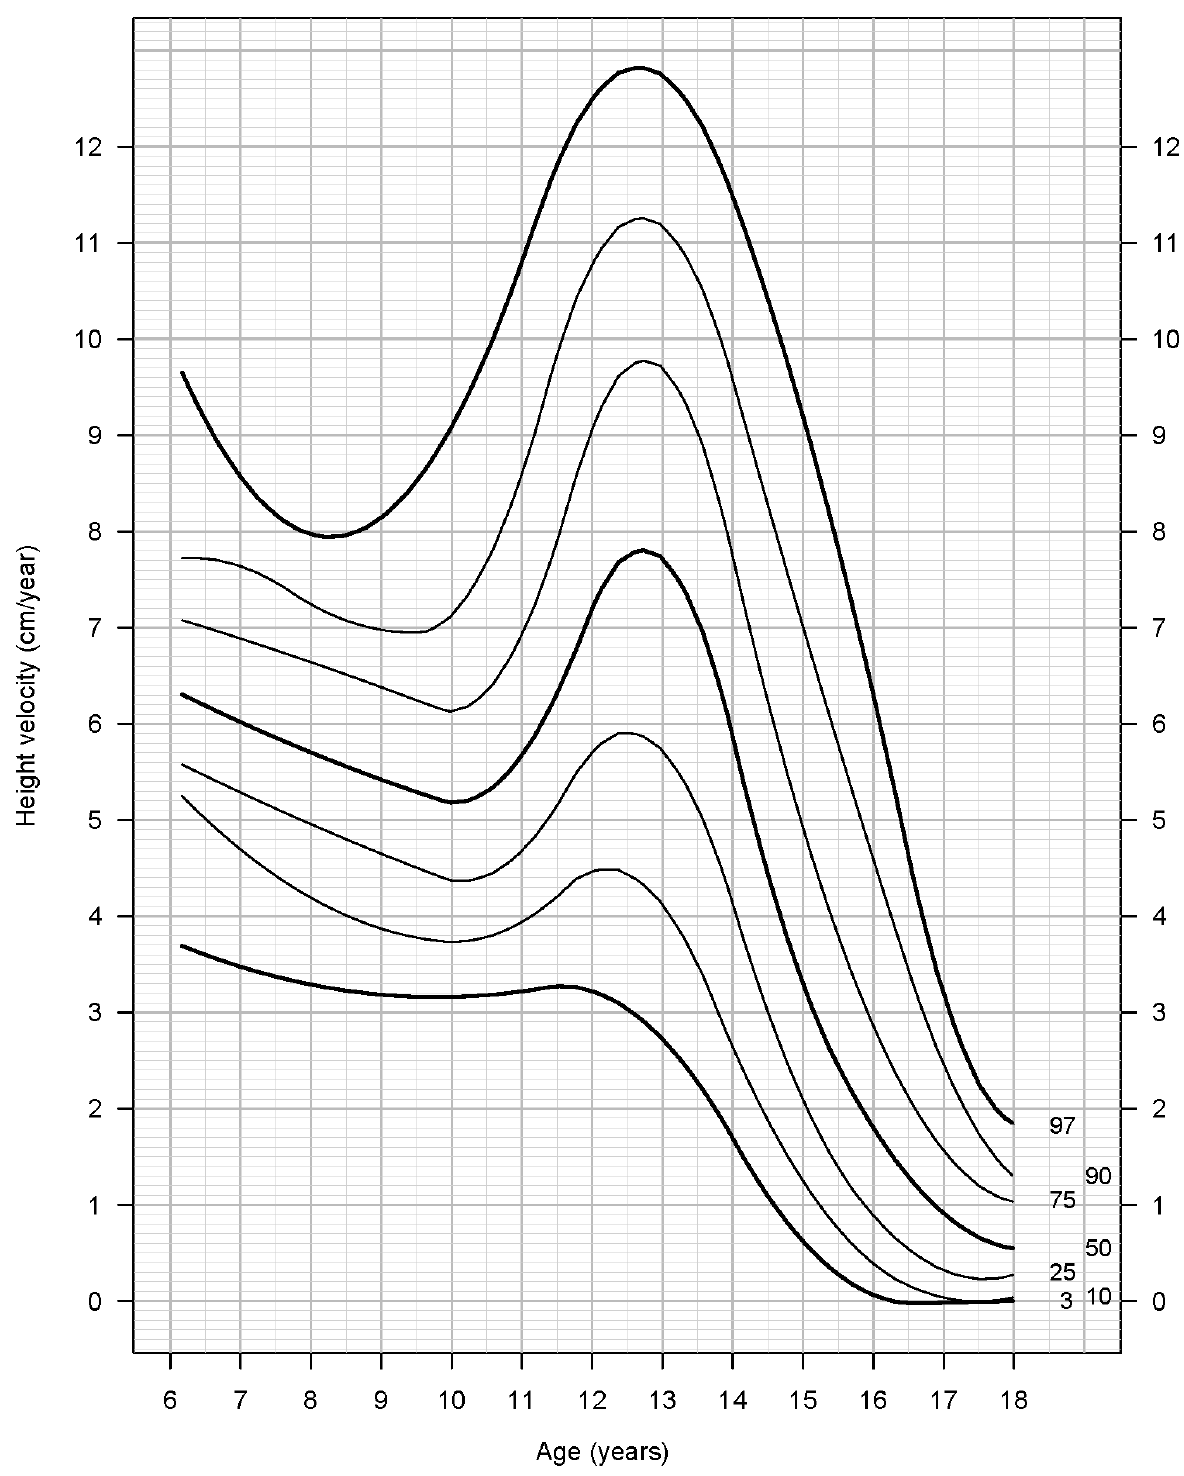
Figure 1. Height velocity for boys. In girls, HV reaches a nadir at the age of 9.06 years (6.45 cm/year) when take-off begins. PHV occurs at the age of 10.93 years (6.76 cm/year) and HV becomes almost zero (<0.5 cm/year), after the age of 16.5 years (final height). From ATO to final height, girls gain a total of 27.3 cm in height, while height gain after PHV is 16.5 cm. The final height of girls was 163.3